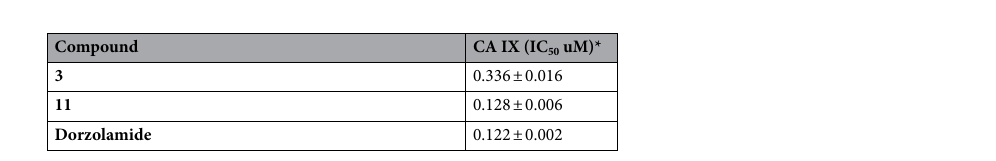
Table 3. In-vitro CA IX inhibitory activity for compounds 3 and 11 . *Results are average of triplicate experiments ± SEM.